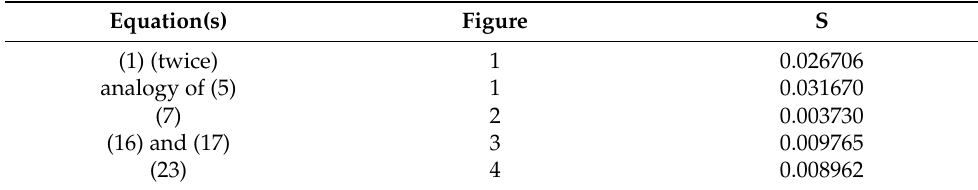
Table 5. Comparison of sums of squares in the Kissinger plot for Ni-Mn-In-Mg shape memory alloy [5] using the presented equations as regression